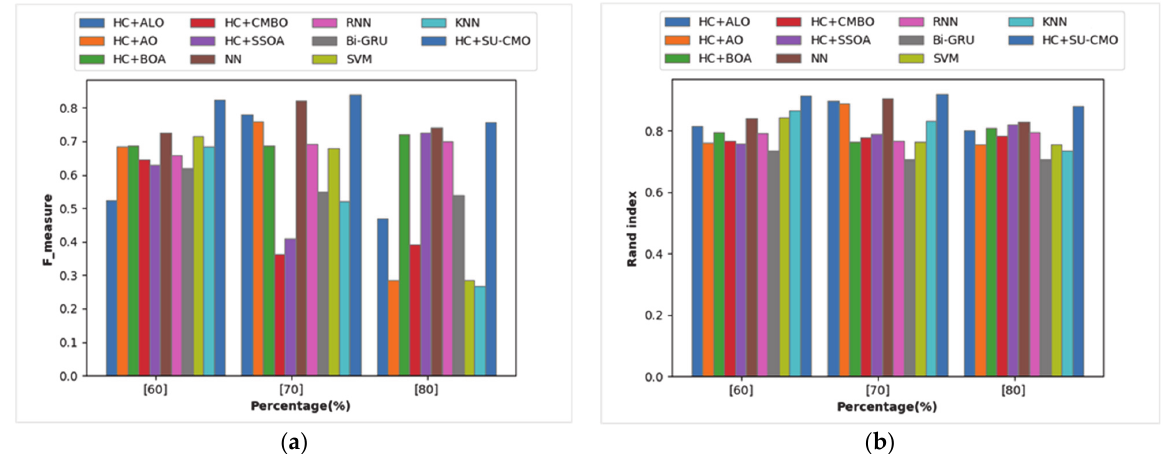
Figure 3. Performance of the adopted model over other existing schemes for dataset 1 ( a ) Accuracy ( b ) MCC.